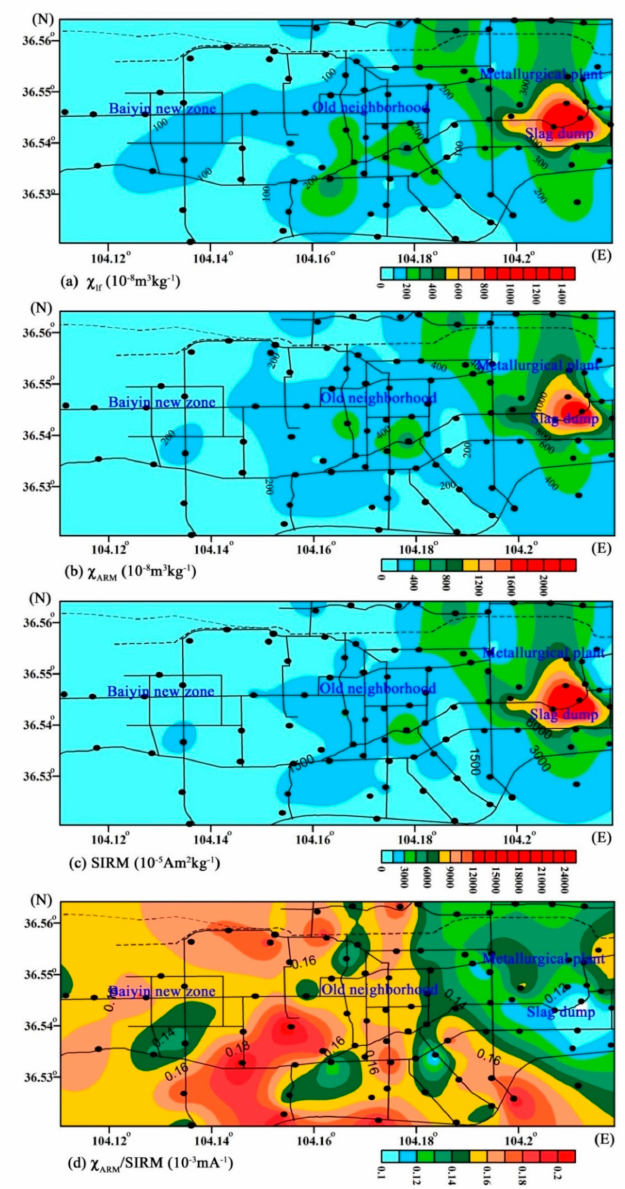
Figure 2. Isoline plot of magnetic parameters of χ lf , χ ARM , SIRM and χ ARM /SIRM for topsoil